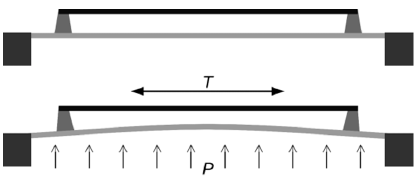
Figure 35. Generation of axial strains in bridges anchored to a flexible membrane due to pressure.